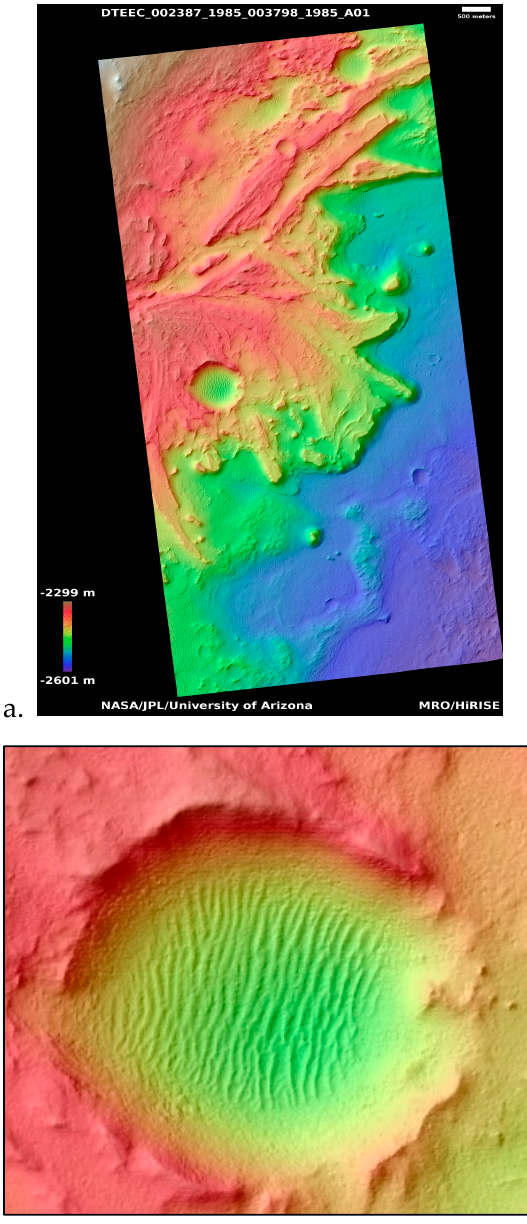
Figure 4. Jezero Crater Delta (Mars 2020 Landing site) ( a ) Color altimetry of digital elevation model. Latitude 18.49° Longitude 77.41°, Scale 1.00 m/pixel. (DTEEC_002387_1985_003798_1985_U01) ( b )